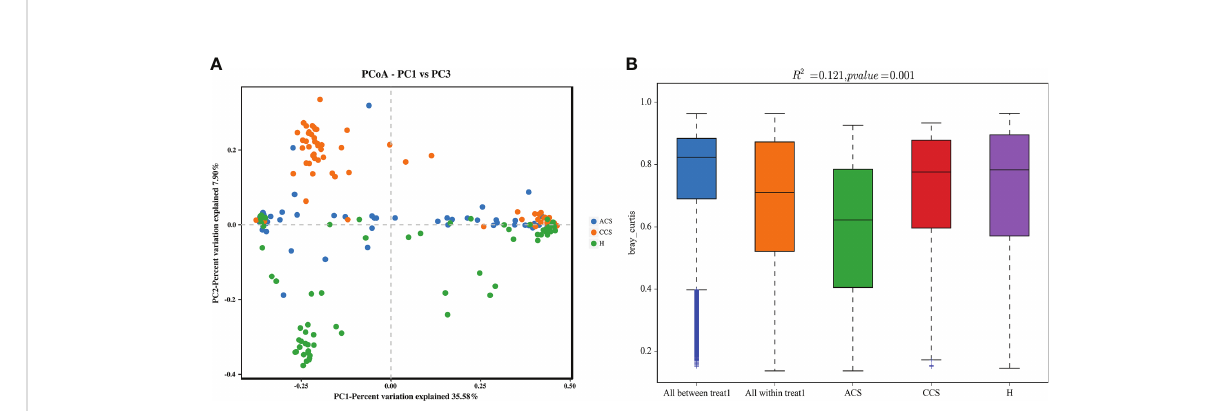
FIGURE 2 (A) Principal coordinate analysis (PCoA) of the overall composition of the genera communities among both groups. (B) PERMANOVA analysis indicates variation in blood bacterial species between HC and MI